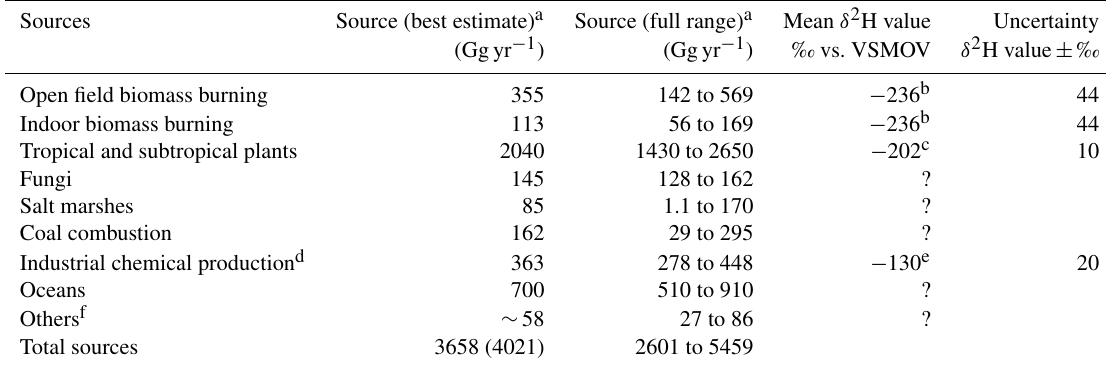
Table 2. Known sources and strengths of tropospheric CH 3 Cl and corresponding δ 2 H